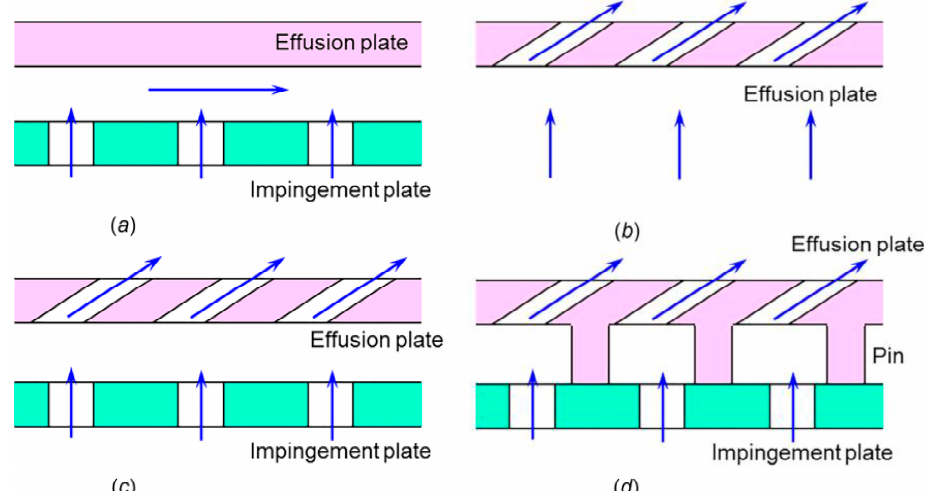
Figure 17. Various cooling configurations: ( a ) pure impingement cooling, ( b ) pure effusion cooling, ( c ) double-wall cooling, and ( d ) double-wall cooling with pins. Adapted with permission from [100]. Copyright 2019 ASME.